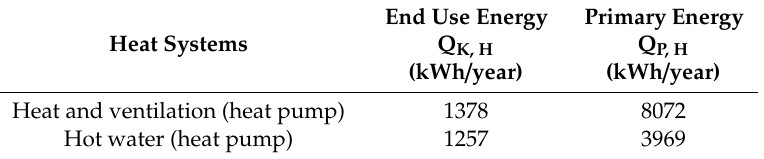
Table 3. Summary of annual primary and end-use energy results.